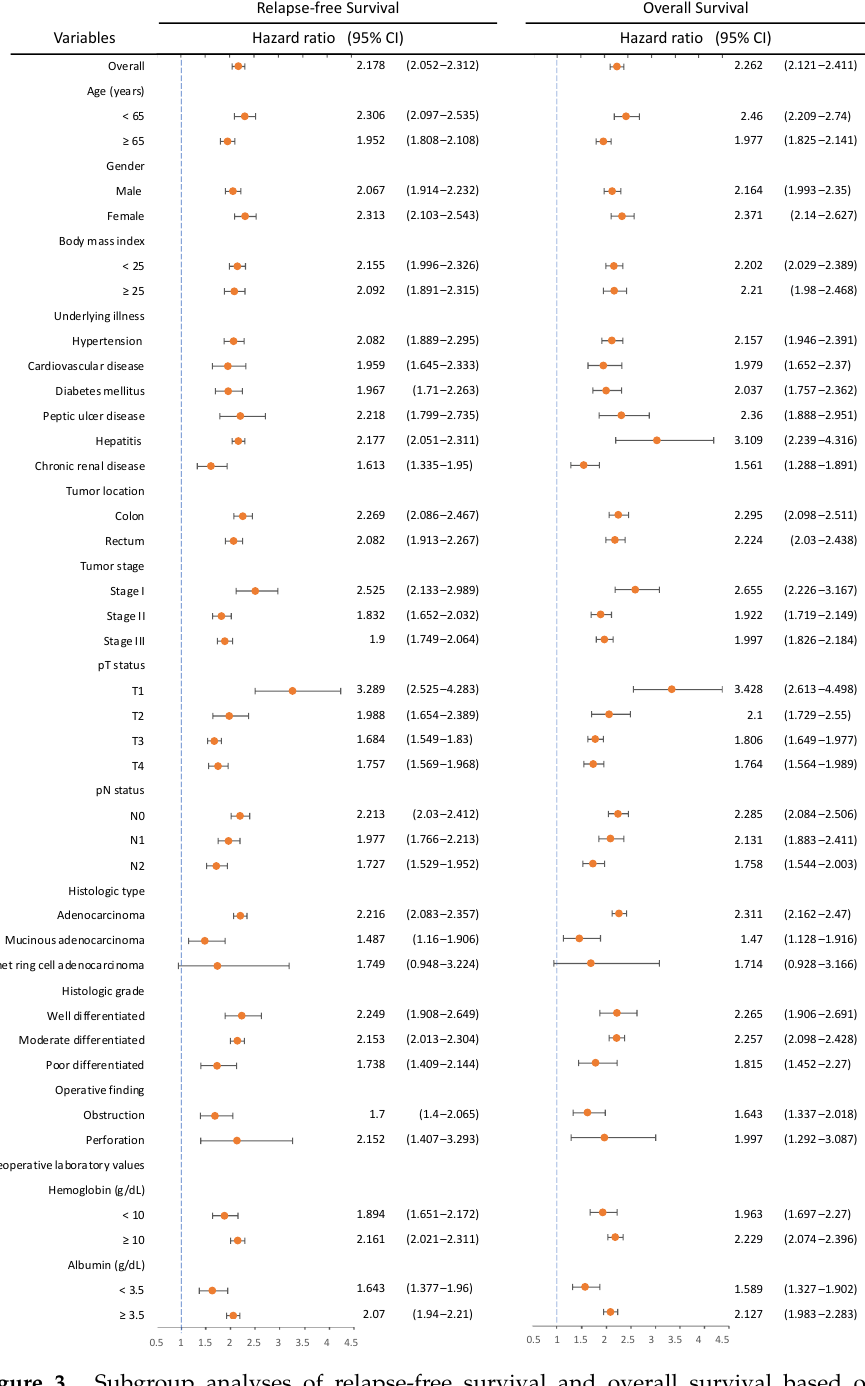
Figure 3. Subgroup analyses of relapse-free survival and overall survival based on cancer- inflammation prognostic index (CIPI)